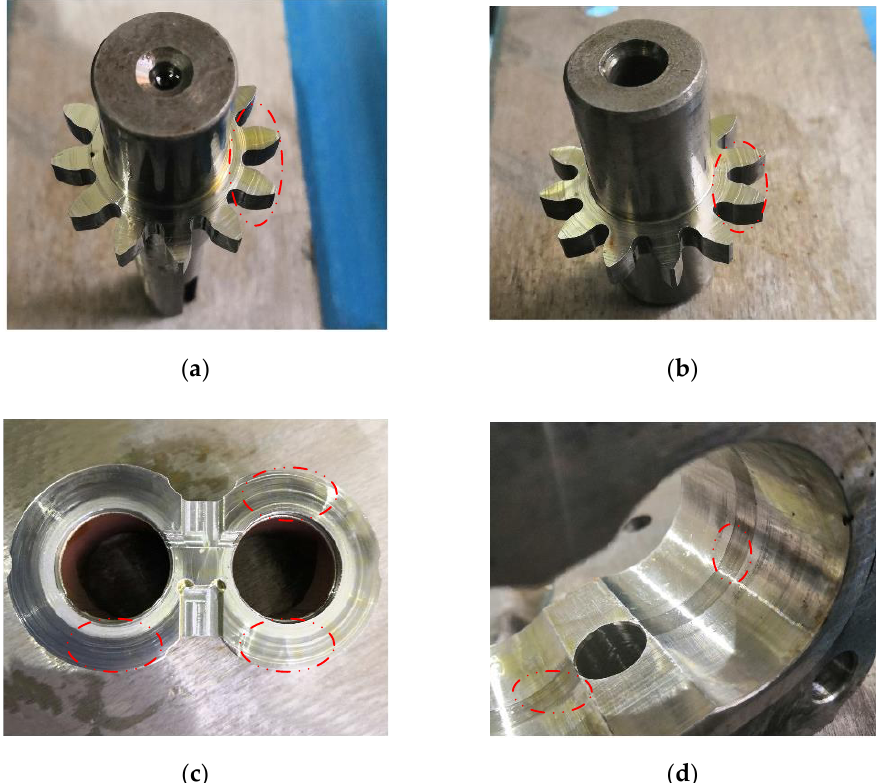
Figure 7. Wear of each component of gear pump: ( a ) End-face wear of driving gear; ( b ) End-face wear of driven gear; ( c ) Side plate wear; and ( d ) Pump body wear.